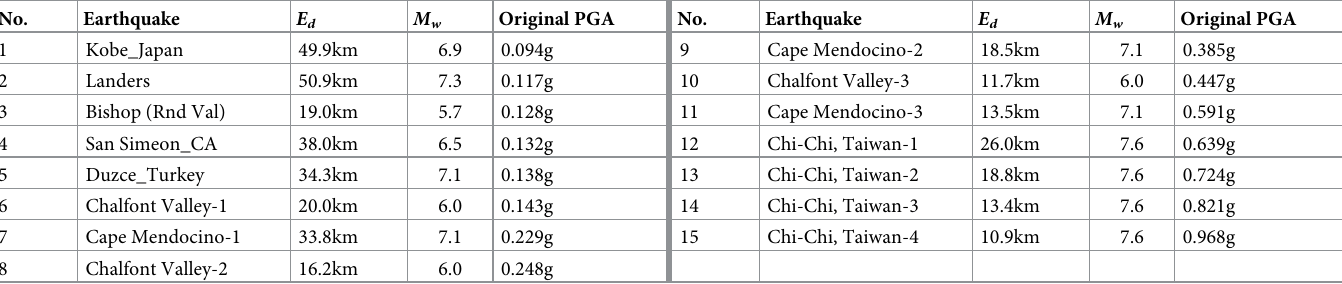
Table 3. Seismic ground-motion